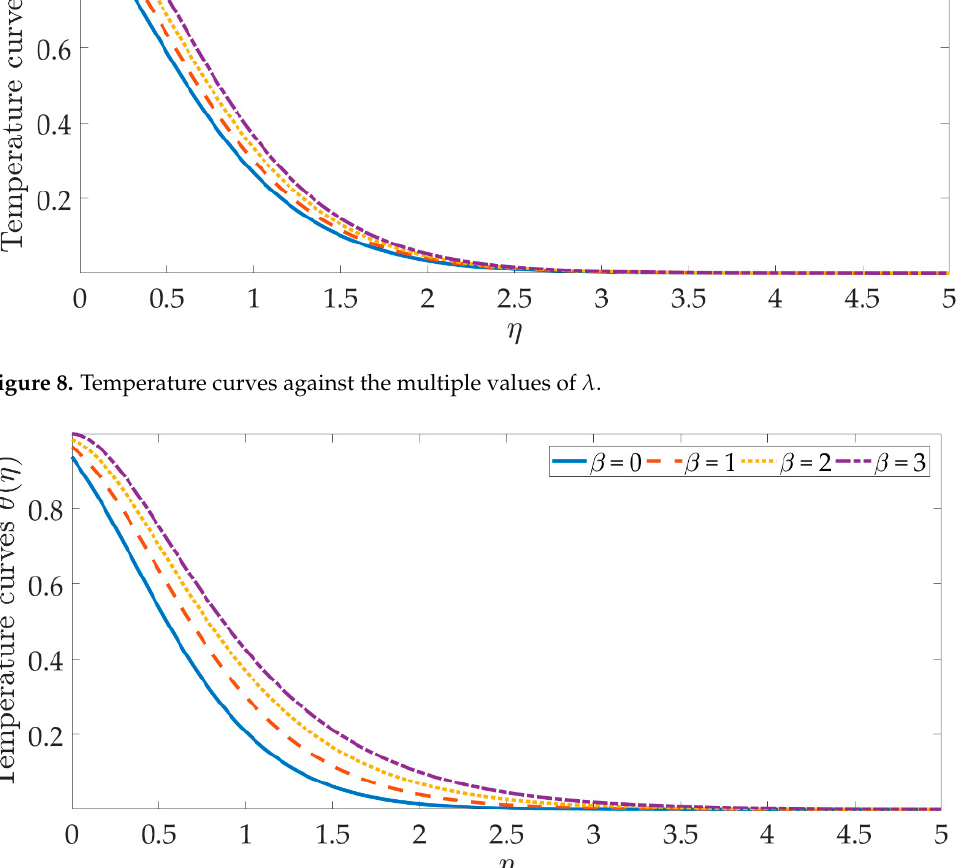
Figure 9. Temperature curves against the multiple values of β